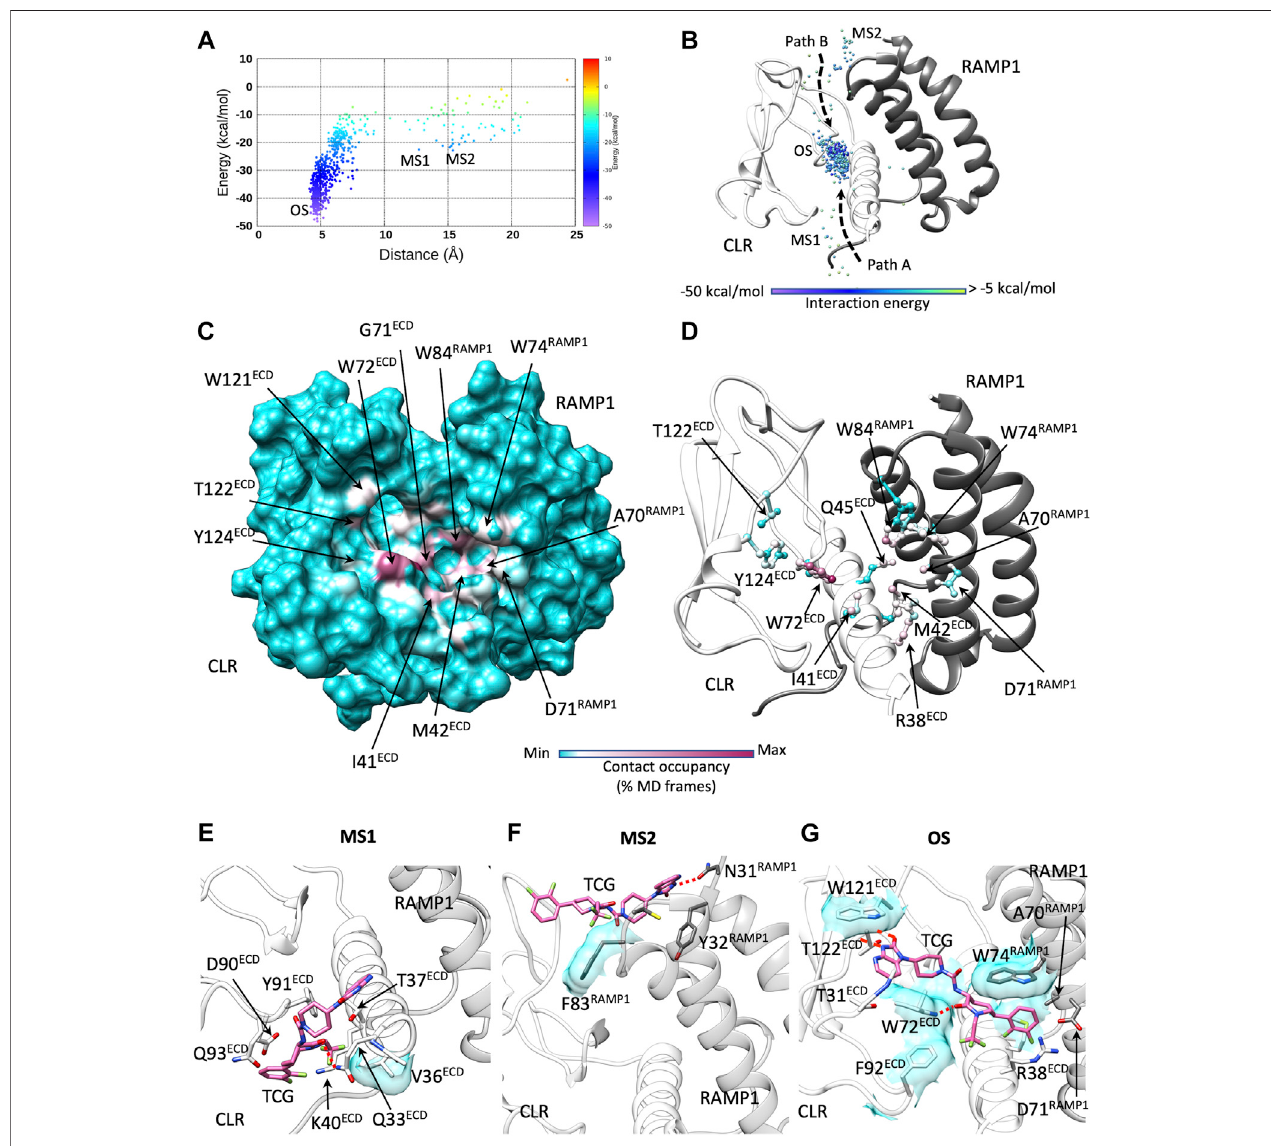
FIGURE 4 | Telcagepant dynamic docking. (A) Telcagepant binding energy landscape (the metastable macrostates, MS1 and MS2, are indicated, alongside the bound states, OS, corresponding to the pose in solved structure); (B) binding paths of the centroid of telcagepant, colored according to the interaction energy with CGRPR (the metastable macrostates, MS1 and MS2, are indicated, alongside the stable bound states OS); (C) Telcagepant-CGRPR contacts plotted on CGRPR surface and colored according to the occupancy (% MD frames) of the interactions; (D) Telcagepant-CGRPR contacts plotted on CGRPR atoms and colored according to the occupancy (% MD frames) of the interactions; (E) representative con fi guration from the macrostate, MS1; (F) representative con fi guration from the macrostate,MS2; (G) representativecon fi gurationfromtheboundstatesOS.Electrostaticinteractionsaredepictedasreddashedlines,whilehydrophobiccontactsare shown as cyan transparent